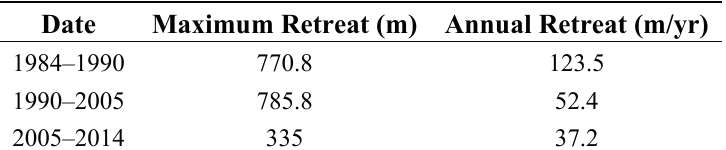
Table 5. Maximum retreat of the shoreline at Rosetta Nile branch promontory through 1984 to 2014 using histogram threshold of Band 5.